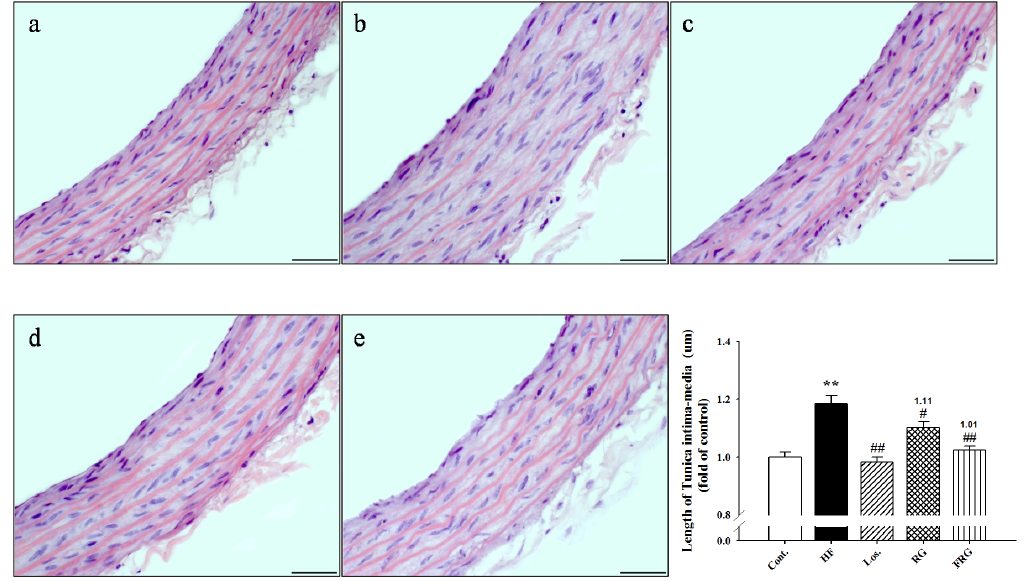
Figure 4. Representative microscopic photographs of H & E stained section of the thoracic aorta in HF diet rats. Lower panel indicated length of intima ‐ media. Lower panel indicated the size of adipose cells (magnification ×400). ( a ) control; ( b ) HF; ( c ) HF + Los.; ( d ) HF + RG; ( e ) HF + FRG. Values were expressed as mean ± S.E. ( n = 3). ** p < 0.01 versus Cont.; ## p < 0.01 versus HF.